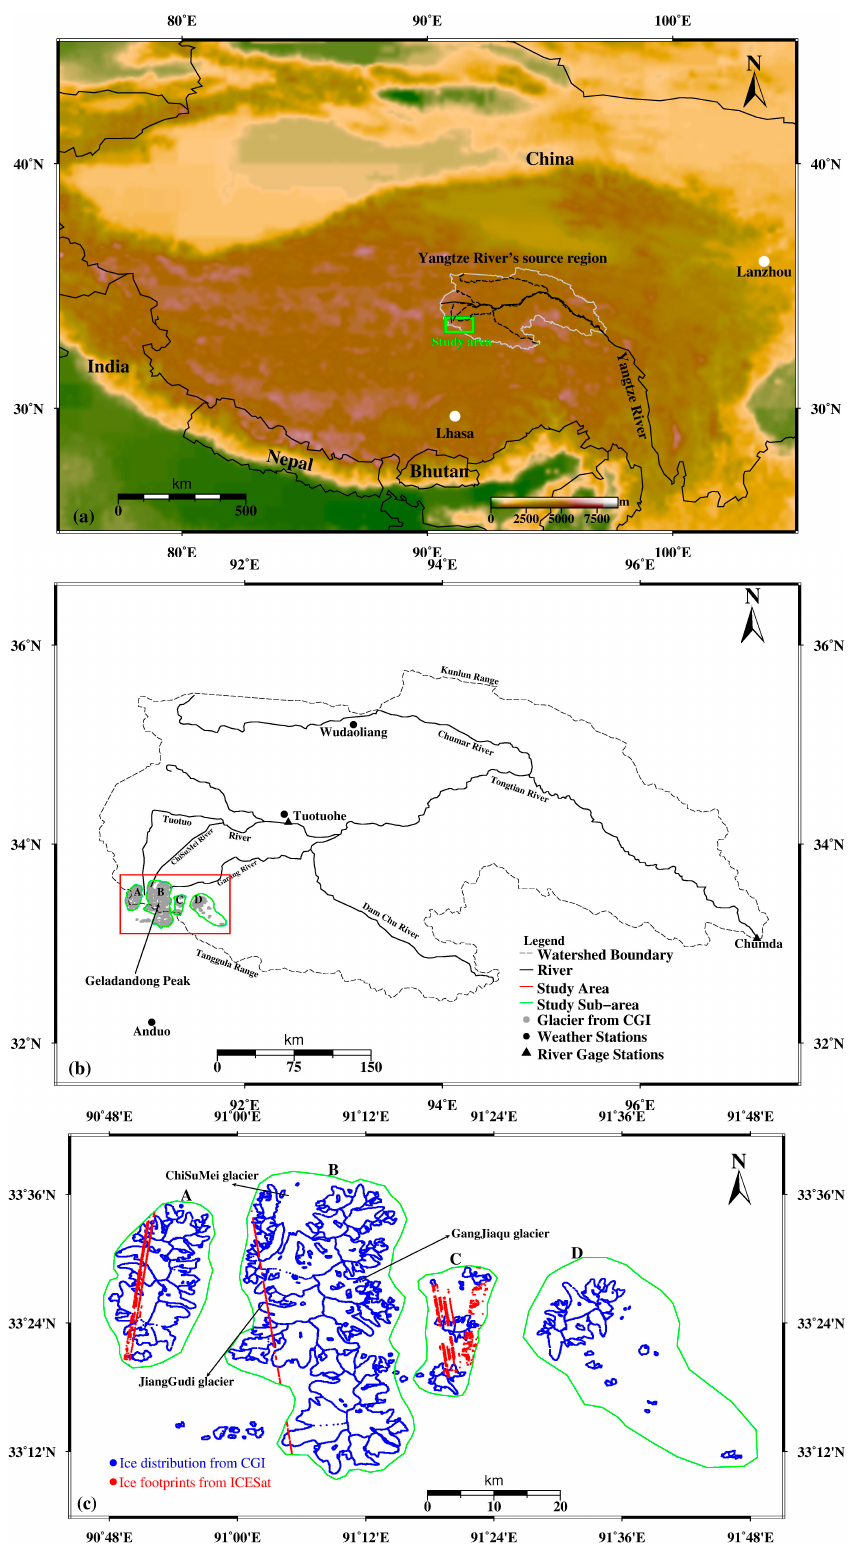
Figure 1. ( a ) The topography of the Qinghai-Tibetan plateau with locations of major rivers in Yangtze River’s source region; ( b ) the Geladandong snow mountain group (bordered by the red box), major rivers in the watershed of the source region, Tuotuohe, Wudaoliang, and Anduo weather stations, and Tuotuohe and Chumda river gauge stations; ( c ) CGI-defined glacier boundaries in Regions A, B, C, and D and Ice footprints from ICESat.